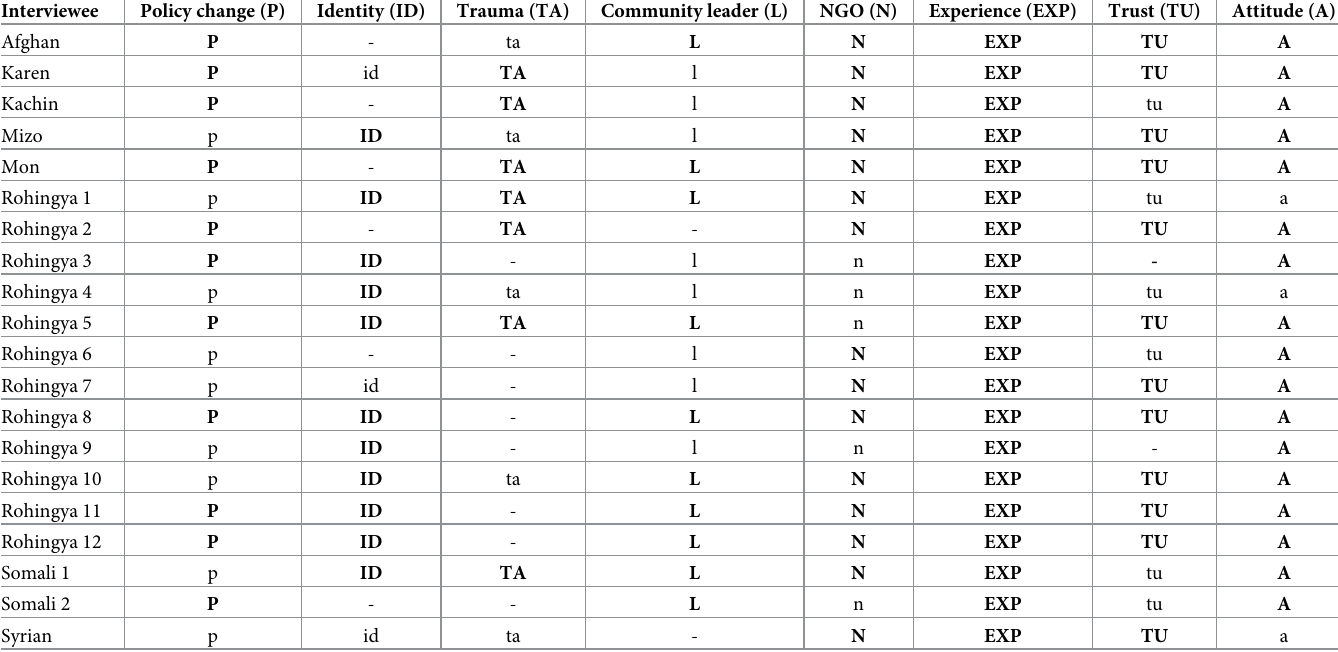
Table 2. Cross-site display of evidence for the process model. Bolded upper-case letters suggest strong evidence of the particular theme from the first round of inter- views, lower-case letters suggest modest evidence of the particular theme from the first round of interviews, and “-” indicates no evidence. Interviewee